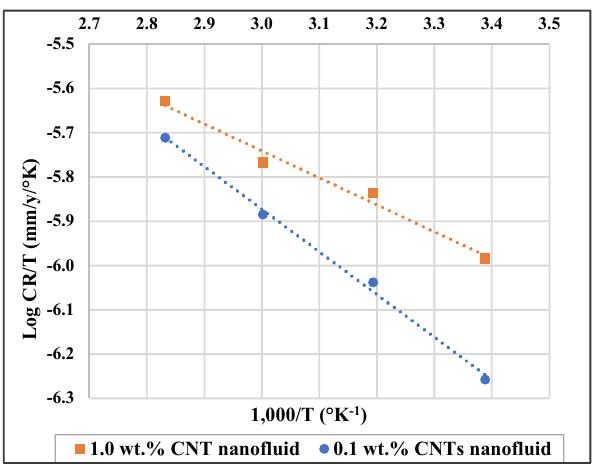
Table 6. Calculated values of thermodynamic parameters for 316L stainless steel tested in 0.1 and 1.0 wt.% CNTs–water nanofluids. Figure 6. Log CR/T versus (1000/T) for 316L stainless steel in 0.1 wt.% and in 1.0 wt.% CNTs–water Figure 6. Log CR/T versus (1,000/T) for 316L stainless steel in 0.1 wt.% and in 1.0 wt.% CNTs–water nanofluids.